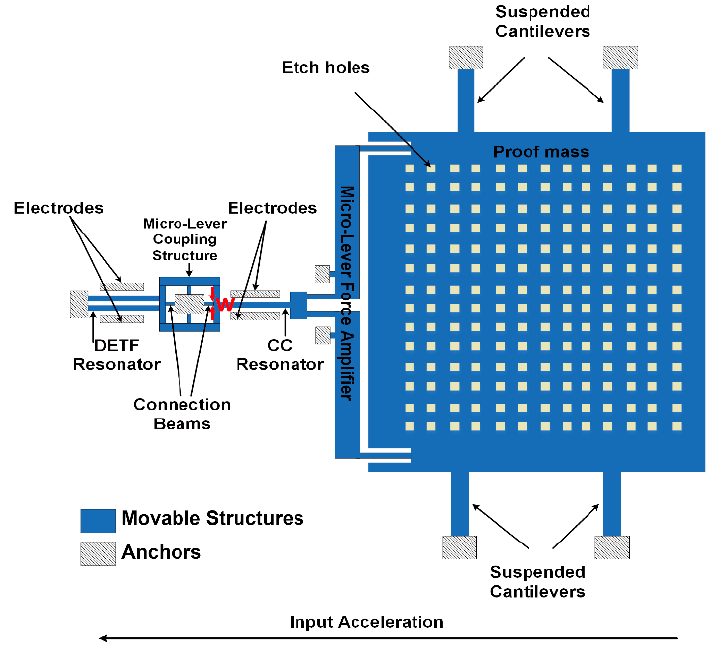
Figure 1. The schematic of the DETF-CC WCRs mode-localized accelerometer with micro-lever coupler